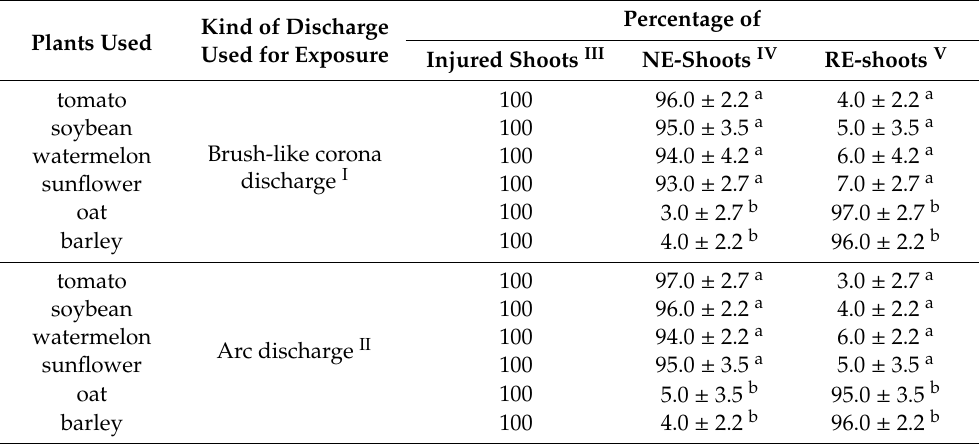
Table 1. Subsequent elongation of plant shoots exposed to arc discharge from iron plates with a − 12 kV